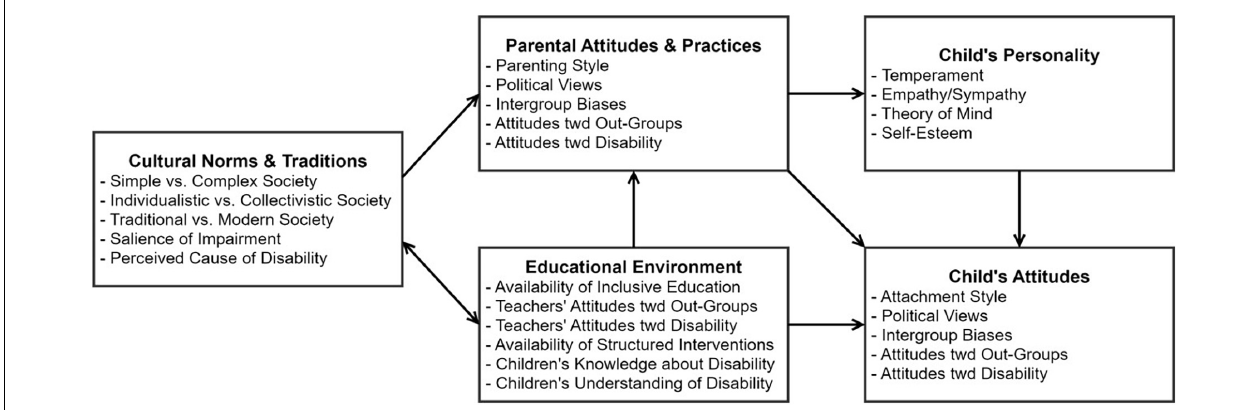
FIGURE 1 | Integrative model providing a conceptual framework for understanding factors influencing the development of disability perception. The current model proposes that children’s attitudes toward disability may be influenced by a range of multi-dimensional factors encompassing different hierarchical levels of the child’s environment. Specifically, cultural norms and traditions guide parental practices and educational environment, which, in turn, shape children’s attitudes toward disability. In this process, parental practices interact with children’s personality traits. For example, an authoritative parenting style may promote secure attachment of the child, which would likely encourage higher self-esteem and empathy, both positively affecting the child’s attitude toward individuals with disability. At the same time, the child’s temperament (e.g., fearful and withdrawn vs. self-confident and social) might alleviate or exacerbate the effects of negative parental practices. Importantly, this model underlines the power of the educational environment to change not only children’s attitudes toward disability, but also parents’ intergroup biases and parental practices, as well as cultural norms in regard to disability perception.